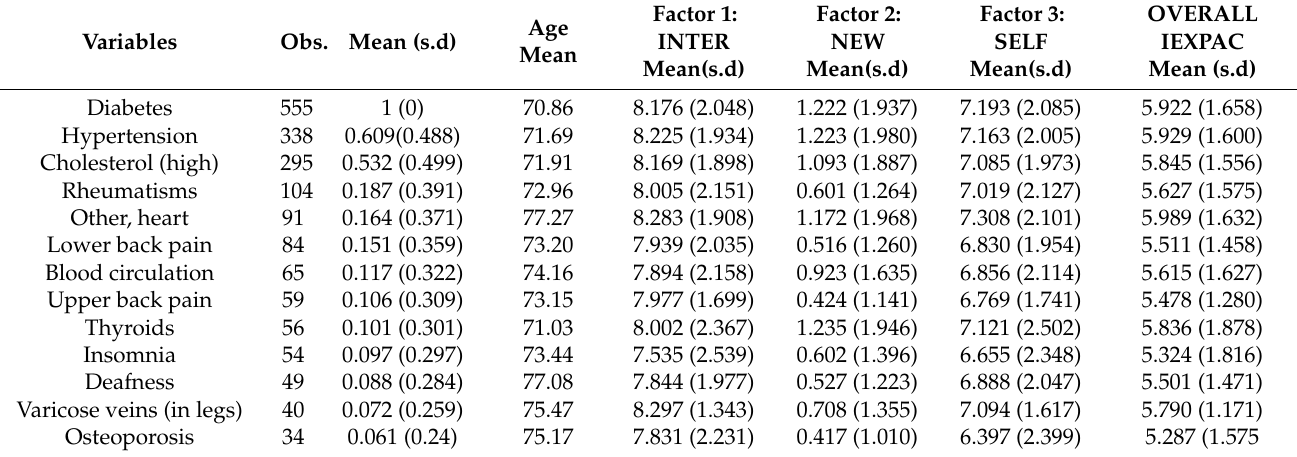
Table 2. Health-related variables: diabetes and comorbid conditions. Descriptive